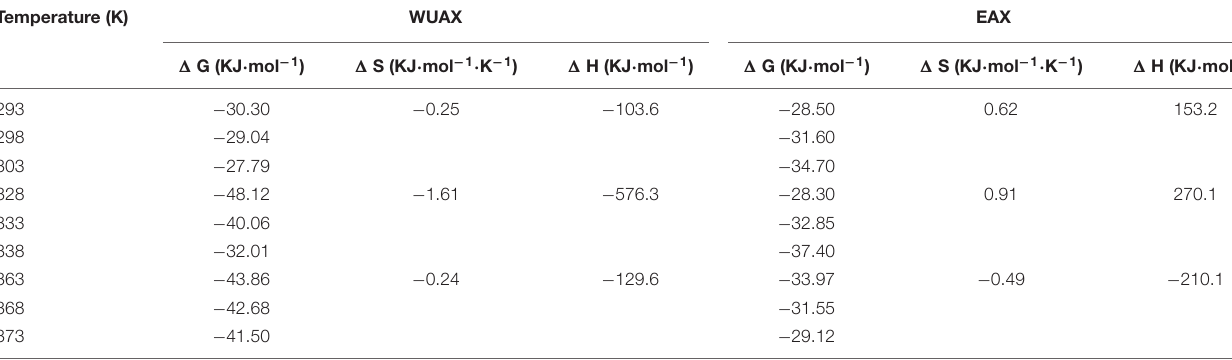
FIGURE 3 | Influence of WUAX and its hydrolysates on gluten microstructure at different thermal treated temperatures by CLSM. (A–E) The temperature of 25 ◦ C. (F–J) The temperature of 60 ◦ C. (K–O) The temperature of 95 ◦ C.The subscript number 1 was the visualized proteins (the red color). The subscript number 2 was the visualized AXs (the blue color). The subscript number 3 was the merged image combined with protein and AXs. Each row represented G, GW3, GW6, GE3, and GE6, respectively. G, gluten; GW3, gluten with 3% (w/w) WUAX; GW6, gluten with 6% (w/w) WUAX;GE3, gluten with 3% (w/w) EAX; GE6, gluten with 6% (w/w) EAX. TABLE 3 | Thermodynamic parameters obtained for gluten-AX interactions from fluorescence spectroscopy. Temperature (K) WUAX